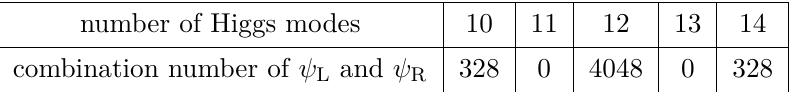
Table 27 . D L = D R = 6 , D H = 24 .